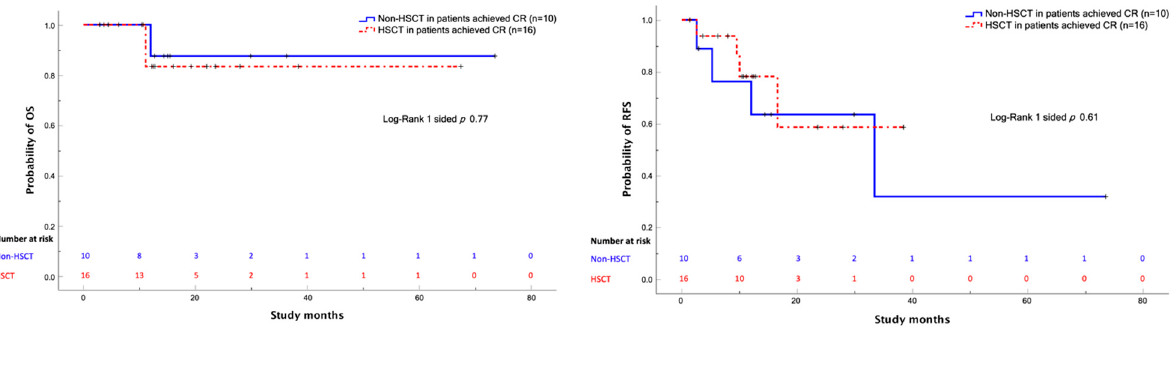
Figure 2. Kaplan-Meier analysis of the OS comparing patients who achieved CR after blinatumomab, and those who did not; log-Rank one-sided p < 0.0001. Abbreviations: OS, overall survival; mo, months; NE, not evaluable.